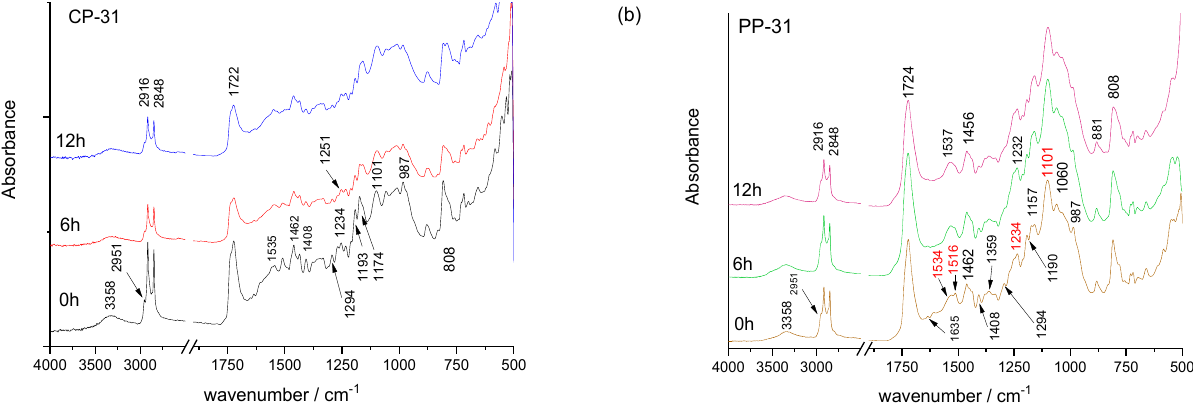
Figure 2. FTIR spectra of the TC31 ink on cellulose-based ( a ) and polypropylene-based ( b ) paper before and after exposure to UV radiation.